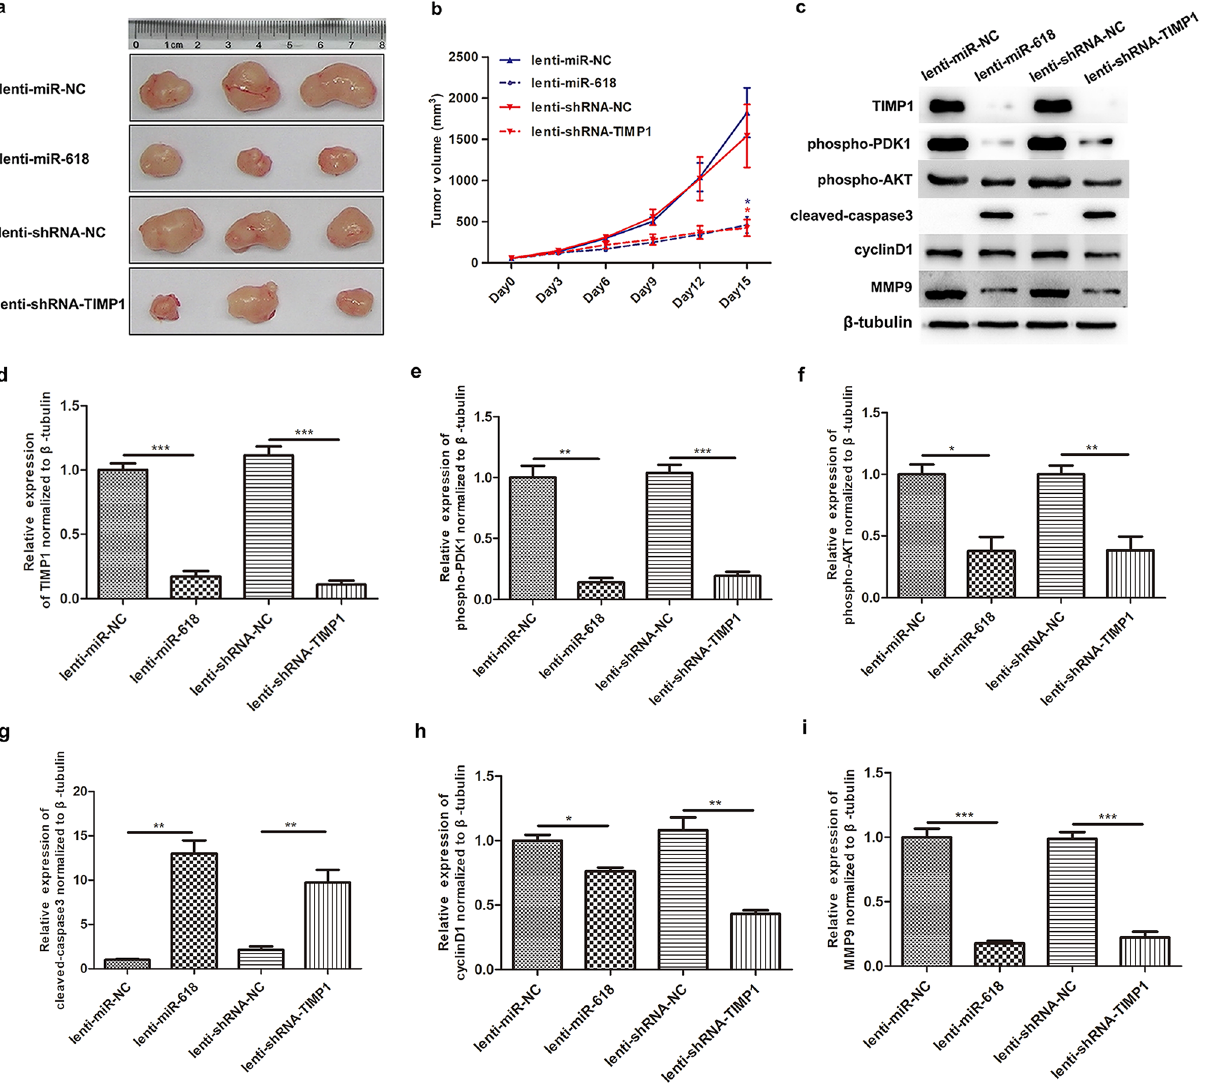
Figure 6. miR-618 suppresses the tumorigenesis of HT29 in vivo via inhibiting TIMP1 expression. ( a ) Representative images of tumors isolated from nude mice transplanted with HT29 subcutaneously. ( b ) Growth curves of tumors above-mentioned. miR-618 over-expression lenti-virus suppressed the growth of subcutaneous xenografts, and so did the TIMP1 shRNA lenti-virus. The significance of the difference between group lenti- miR-NC and group lenti-miR-618 is indicated in blue, as the significance of the difference between group lenti-shRNA-NC and lenti-shRNA-TIMP1 is indicated in red. * P < 0.05 (t-test). ( c ) Malignant phenotype related regulators were detected by western blot in tumors above-mentioned. ( d – i ) Followed grayscale value analysis of these regulators in tumors. Data are reported as means ± SD of three independent experiments, and statistical analyses are done for groups with lines, and the adjusted p value are represented above the lines. * P < 0.05,** P < 0.01, *** P < 0.001, and ns (not significant) with P > 0.05